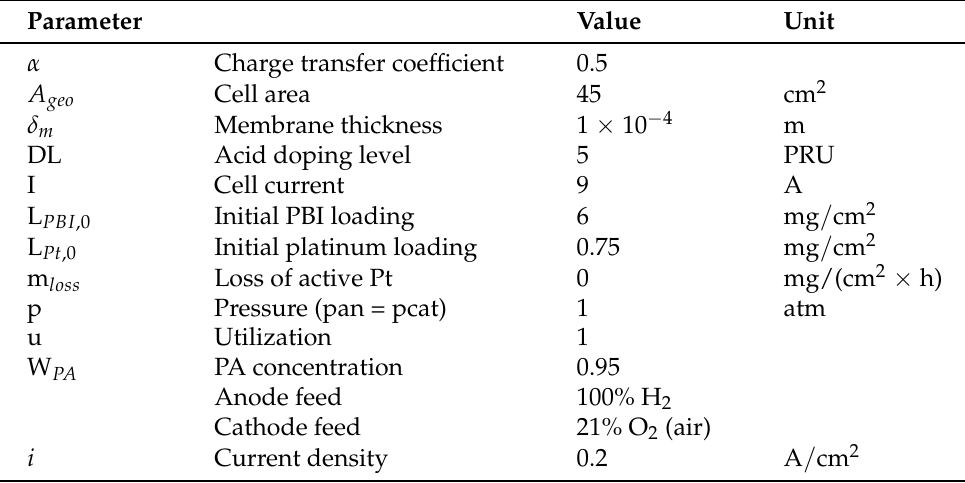
Table 3. Parameters used in this model if not stated otherwise